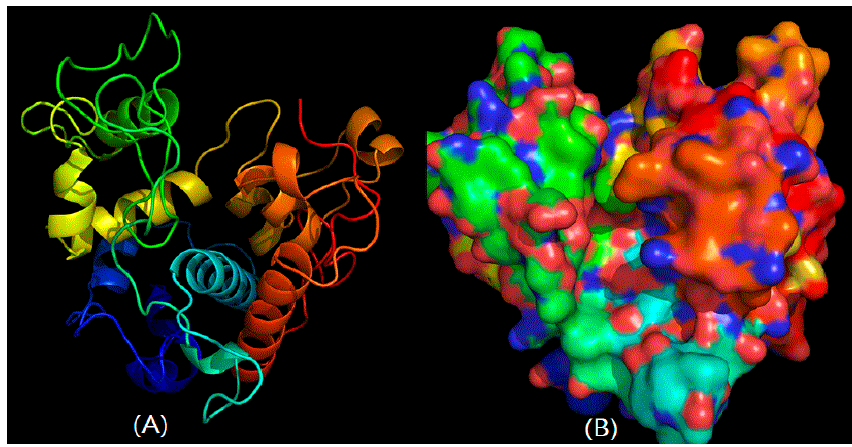
Figure 3. The predicted ribbon-model structure ( A ) (The PDB number is 2Z38) and surface ( B ) of CHI2 chitinase from SYBC-H1. Solvent-accessible surface representation colored by residue type (acidic residues red, basic residues blue, polar residues green, nonpolar residues white).